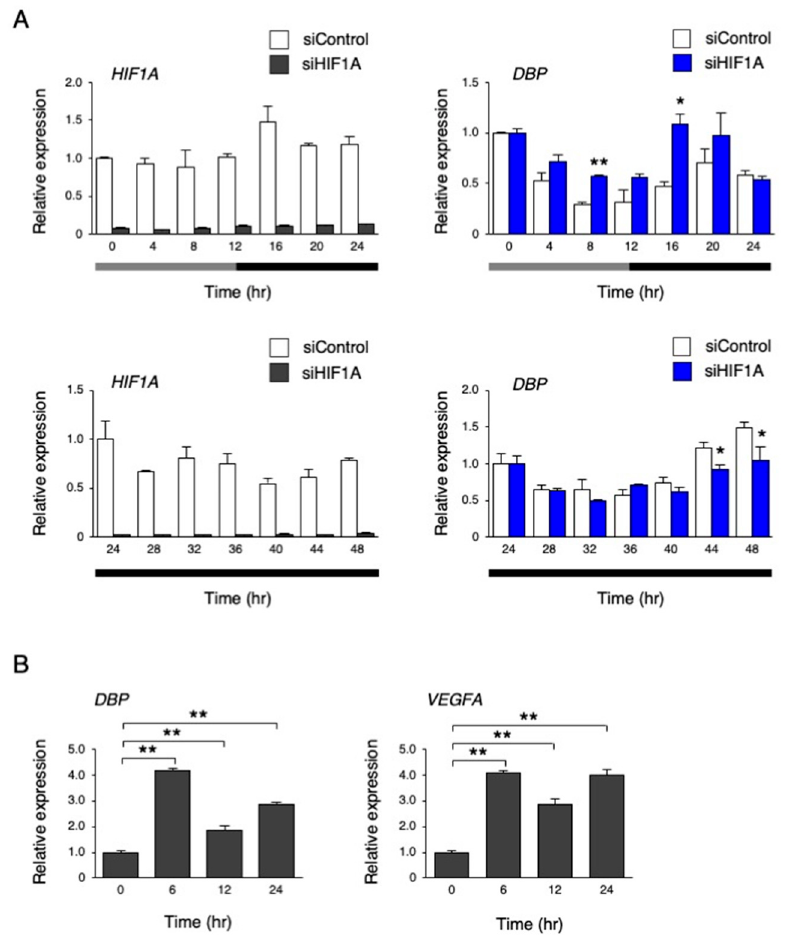
Figure 10. The effect of inhibiting HIF-1 α on the circadian-like rhythm of DBP expression. ( A ) The expression levels of HIF1A and DBP under the temperature rhythm in hiPSCs treated with siControl or siHIF1A; 0 h refers to the start of day 5 of the temperature rhythm. The temperature was set at 33 °C from 0 to 12 h (gray bar) and then at 37 °C from 12 to 24 h and 24 to 48 h (black bar). Data are presented as the means ± SEM. The left graph shows the relative value to 0 h or 24 h of siControl, and the right graph shows the relative value for 0 h or 24 h, for siControl and the target siRNA; n = 3 for each comparison. A two-way repeated measure ANOVA revealed significant differences between siControl and siHIF1A (0 to 24 h, p < 0.01; 24 to 48 h, p = 0.02). Asterisks show the significant differences at each time point, with * p < 0.05, ** p < 0.01 (Student’s t-test). ( B ) The expression levels of DBP and VEGFA under a hypoxic condition (1% O 2 ) in hiPSCs. Data are presented as the means ± SEM relative to 0 h; n = 3 for each comparison. ** p < 0.01 versus each value at 0 h.